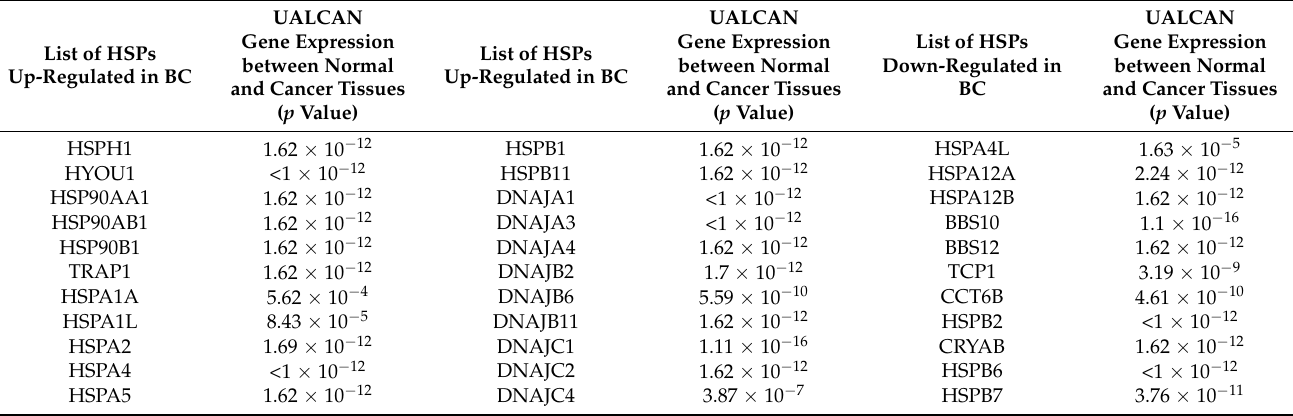
Figure 1. Gene expression analysis of HSP members between normal and breast cancer samples analyzed by UALCAN database. ( A ) Box plots of HSP genes up-regulated in BC compared to normal tissues. ( B ) Box plots of HSP genes down-regulated in BC compared to normal tissues. p < 0.01 was considered significant. Table 2. List of HSP members significantly up and down-regulated in BC analyzed in UALCAN